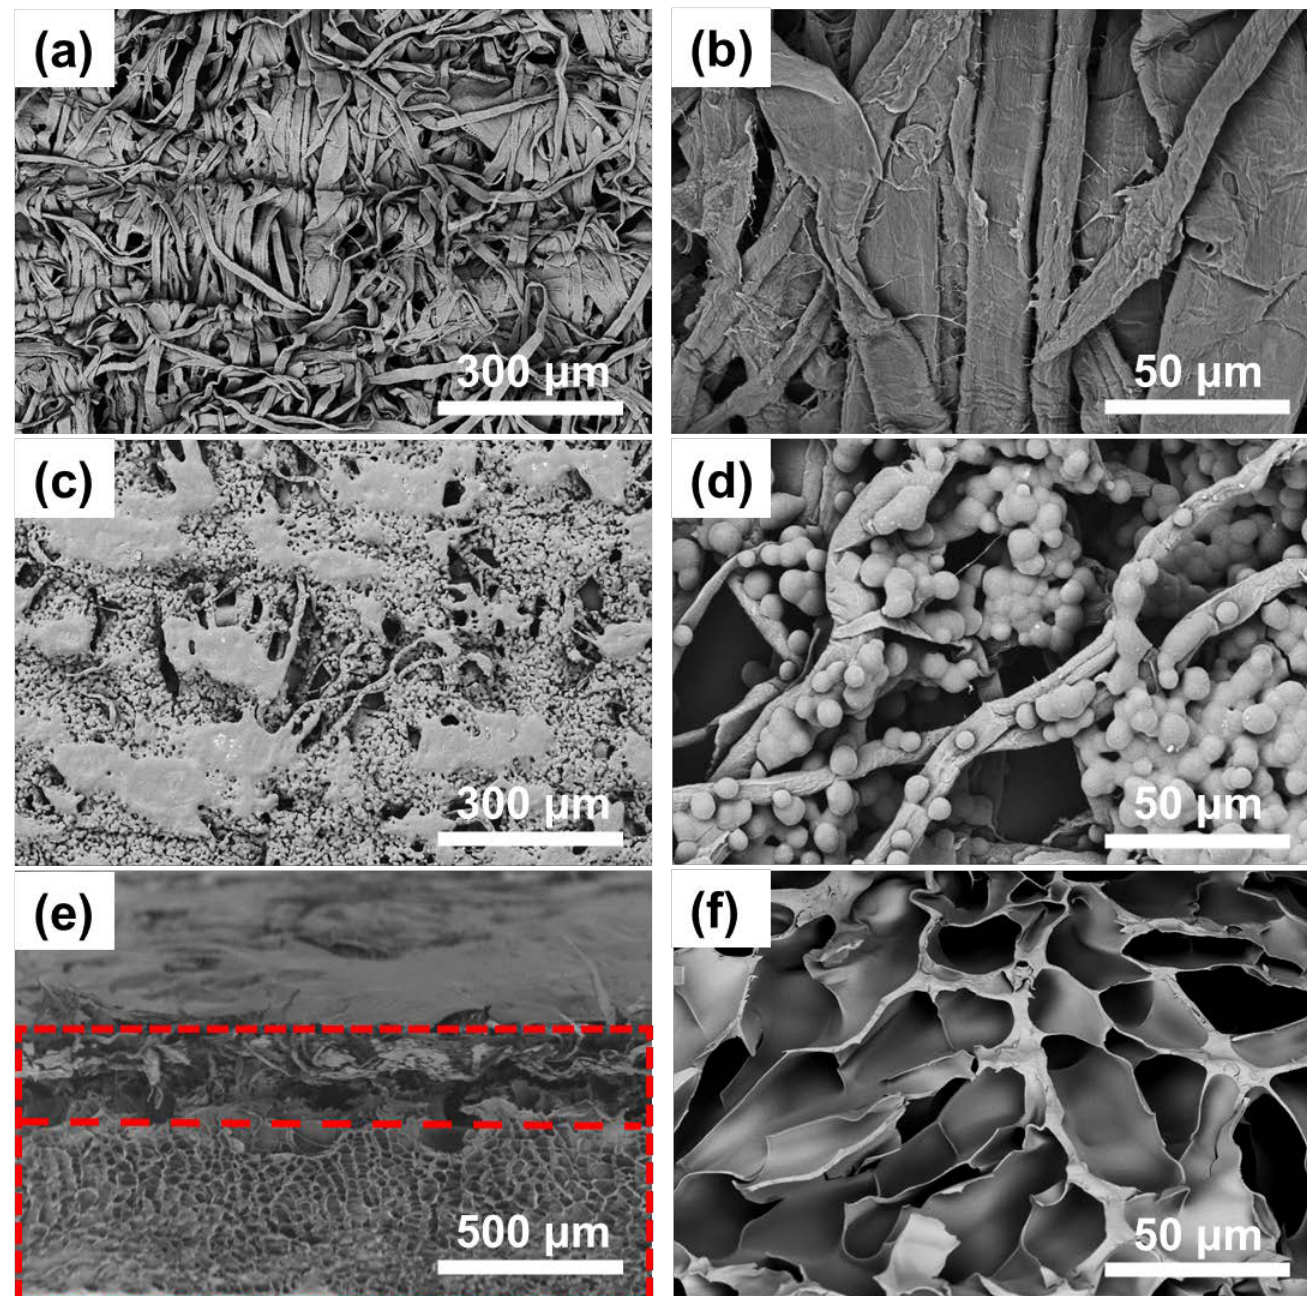
Figure 2. ( a , b ) The SEM images of tissue paper. ( c , d ) The SEM images of black tissue paper. ( e ) Tissue paper/PNIPAM hydrogel composite actuator structure. ( f ) The SEM image of pure PNIPAM hydrogel.